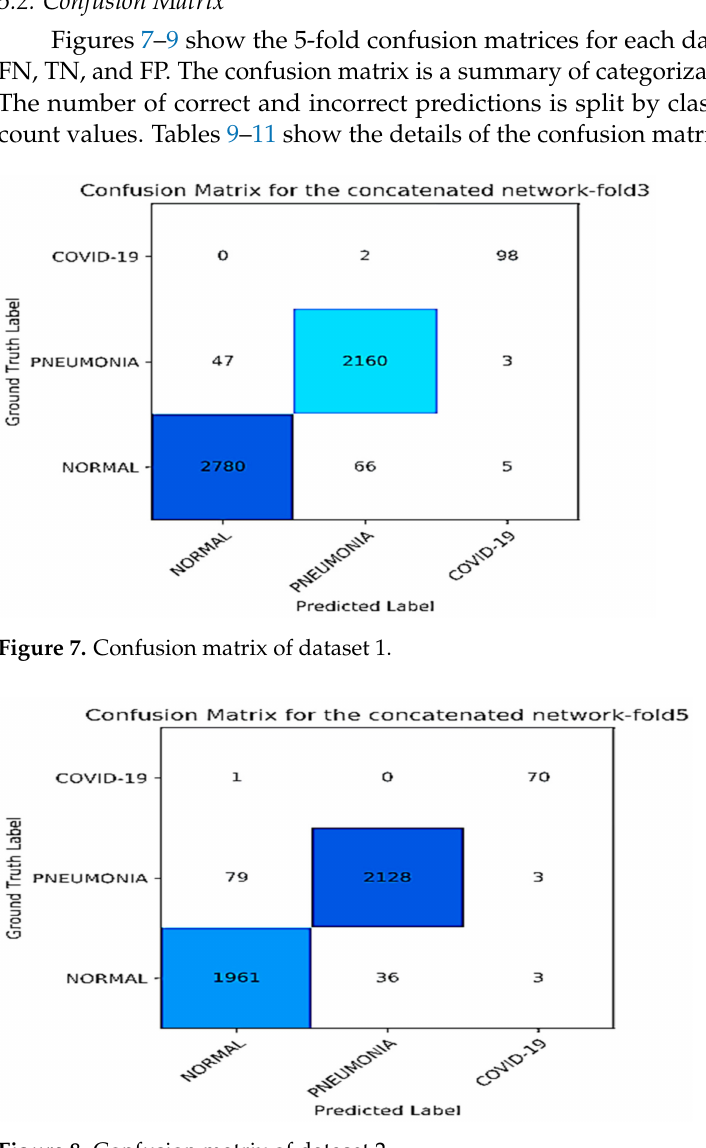
Figure 8. Confusion matrix of dataset